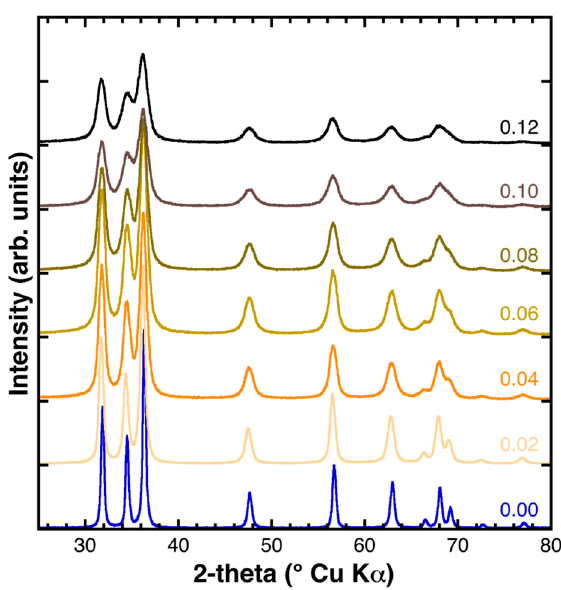
Figure 1. Powder X-ray diffraction (XRD) patterns of the as synthesized samples. The Fe fraction is indicated at the right side above each diffractogram. Table 1. Structural parameters, average crystallite size, and disagreement indexes of the Rietveld refinements performed using isotropic temperature factors and isotropic broadening of the diffraction reflections. The errors of the Unit cell parameters and <T–O> distances are provided in